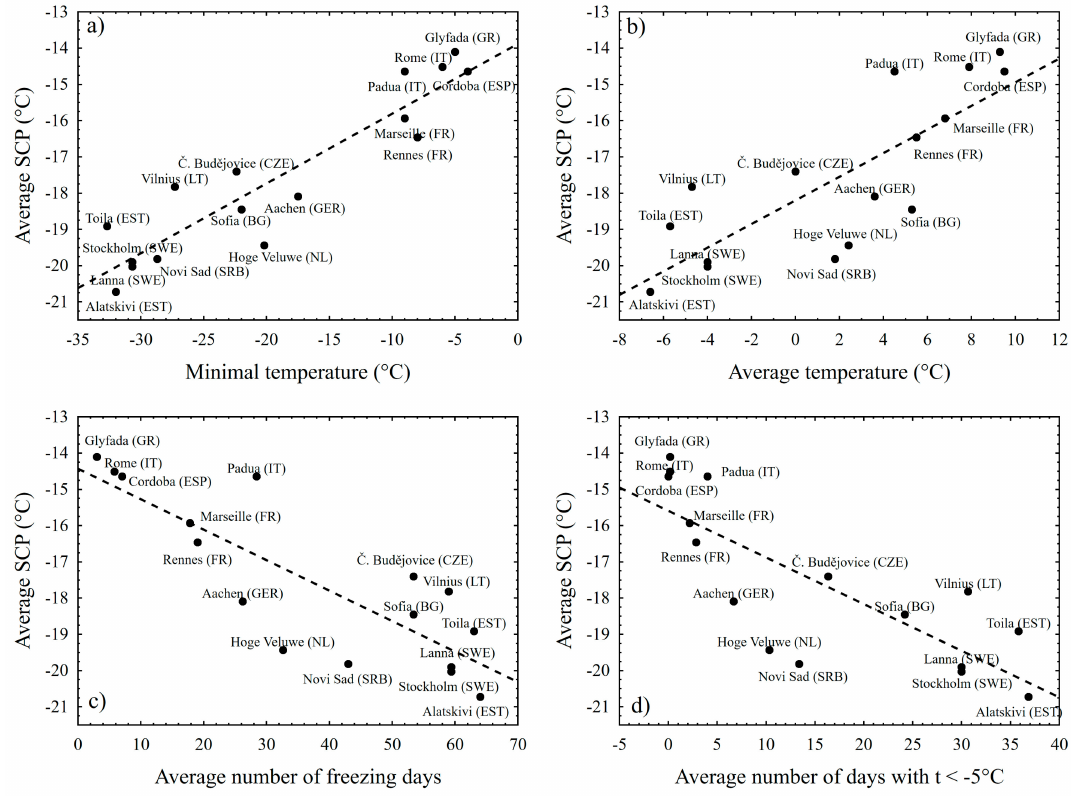
Figure 3. Average population SCP as a linear function of climatic conditions (January–February during 2010–2015). All investigated climatic factors are significantly correlated with the mean population SCP, but the extent of explained variability slightly differs: ( a ) strong correlation with minimum temperature explained 85% of SCP variability; ( b ) the winter average temperature explained 64% of SCP variability; ( c ) the number of freezing days explained 69% of SCP variability; and ( d ) number of days with minimum temperature below − 5 ◦ C explained 63% of SCP